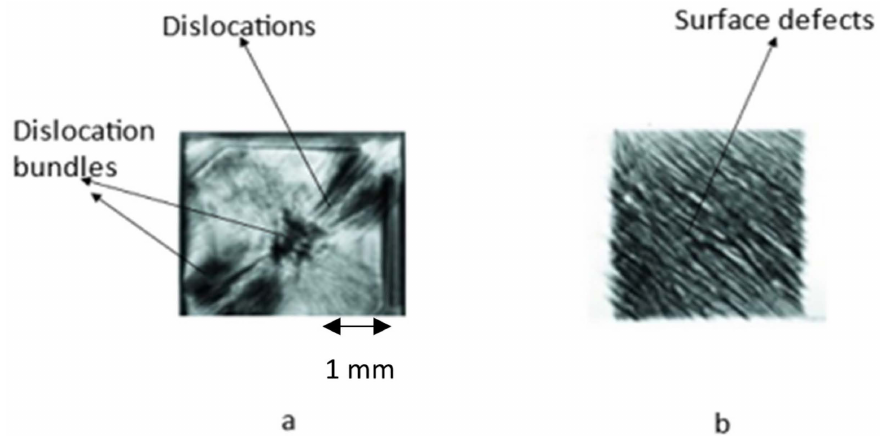
Figure 3. The XRT images of two plates of type Ib HPHT diamond of the size 3 mm × 3 mm. The dark and grey colour contrast lines in ( a ) represent dislocation lines emanating from the centre 1 .The sample in ( b ) is full of surface defects perhaps of mechanical origin (please see the text). The diffraction vector (220) points along the diagonal of the figure. The image is taken from ref. [1]: Tran Thi, T.N.; Morse, J.; Caliste, D.; Fernandez, B.; Eon, D.; Härtwig, J.; Barbay, C.; Mer-Calfati, C.; Tranchant,